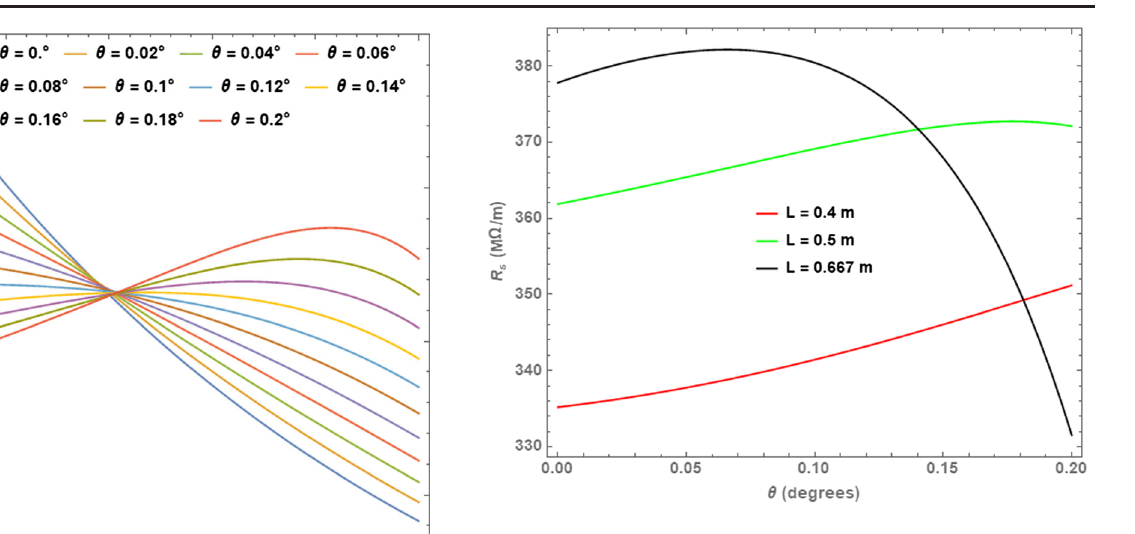
FIG. 15. The effective shunt impedance per unit length for varying structure lengths L as a function of tapering angle θ . s